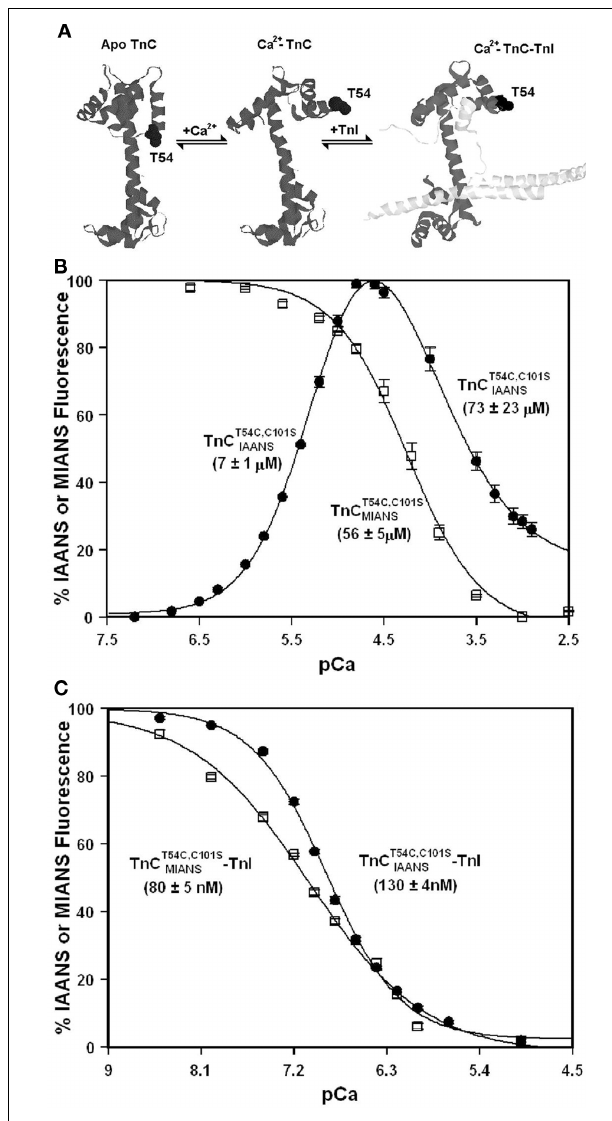
± TnI. (A) Shows a helical FIGURE 2 | Calcium binding toTnC T54C,C101S IAANS representation of apoTnC and Ca 2 + saturatedTnC ± TnI withT54 depicted in space fill format.The Protein Data Bank files utilized for this figure were 1TOP (apoTnC; Satyshur et al., 1994), 2TN4 (Ca 2 + –TnC; Houdusse et al., 1997), and 1YTZ (Ca 2 + –TnC–TnI,TnT is not shown for clarity;Vinogradova et al., 2005) and were rendered using Rasmol (Sayle and Milner-White, 1995). (B) Shows the Ca 2 + dependent increase and decrease in IAANS fluorescence forTnC T54C,C101S